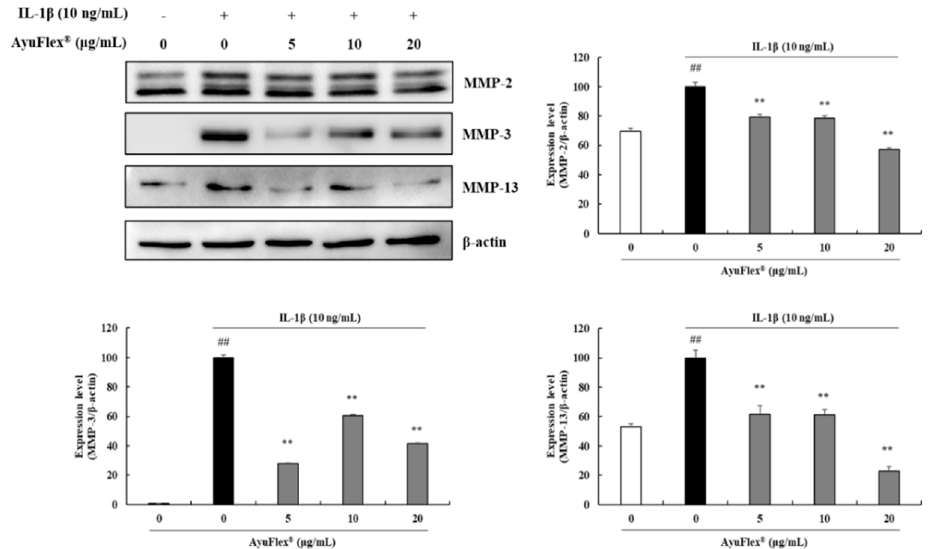
Figure 3. AyuFlex ® diminished the production of MMP-2, -3, and -13 in IL-1 β -treated HCHs. HCHs were treated with IL-1 β (10 ng / mL) single or in combination with AyuFlex ® (5, 10, and 20 µ g / mL) for 24 h. The expression of MMP-2 (62, 72 kDa), MMP-3 (54 kDa), and MMP-13 (54 kDa) was detected by western blot analysis. Protein bands were quantified utilizing ImageJ. As the control for normalization, β -actin was utilized. ## p < 0.01, in comparison with the vehicle control group. ** p < 0.01, in comparison with the IL-1 β -treated control group.